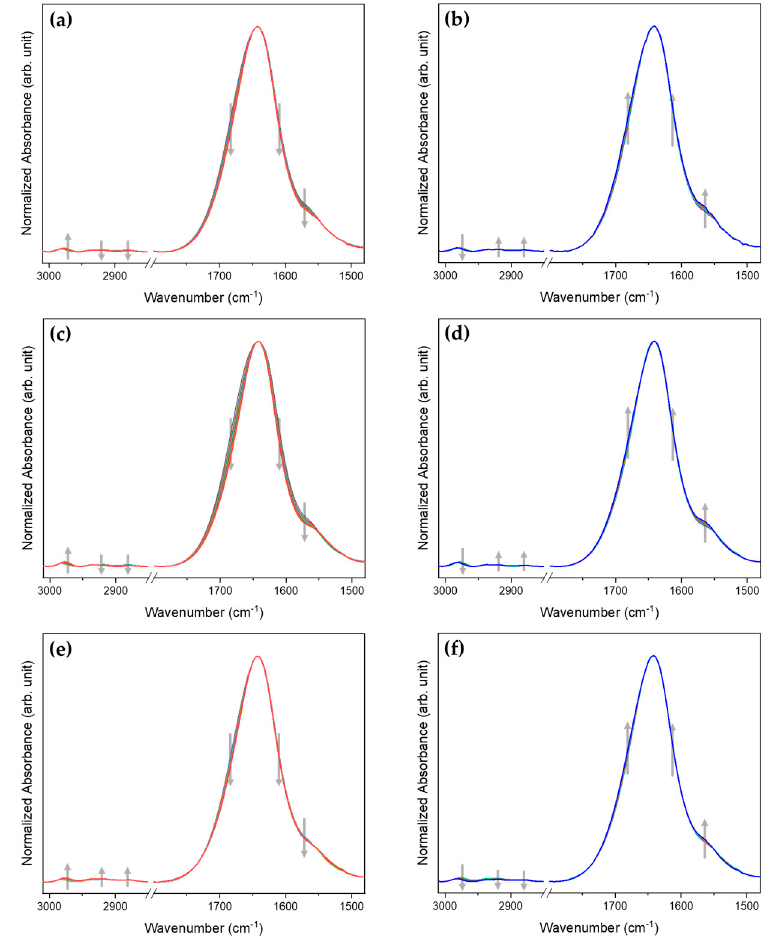
Figure 1. Temperature-dependent IR spectra of P(NiPAAm- co -AAc) hydrogel of pH4 ( a , b ), pH3 ( c , d ), pH2 ( e , f ) during the heating ( a , c , e ) and cooling ( b , d , f ) processes. The gray arrows indicate the direction of intensity change with varying temperature; from 27 to 40 °C is during the heating process and from 40 to 27 °C is during the cooling process.